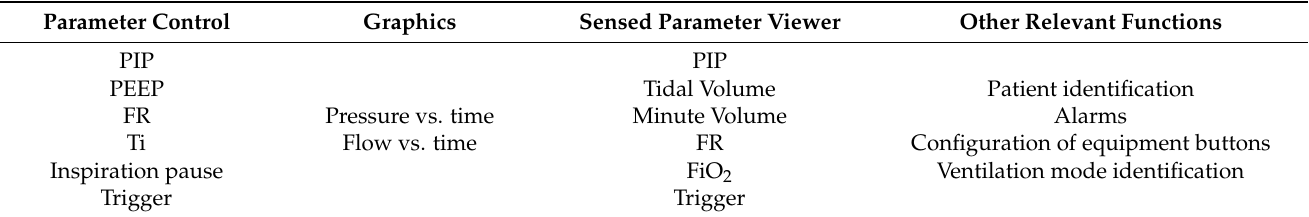
Table 4. Useful components for user interface design used in the emerging mechanical ventilator [23].